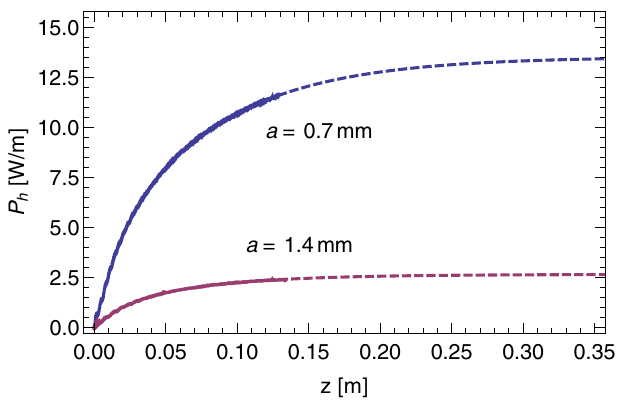
FIG. 12. Beam on axis between two plates: Joule power calculations obtained by time-domain simulation, for plate half aperture a ¼ 0 . 7 mm (blue) and a ¼ 1 . 4 mm (blue). The beam traverses the plate from its beginning, at z ¼ 0 , to its end, at FIG. 14. The real value of the impedance Re ð Z Þ for the single- z ¼ 0 . 135 m. The dashed lines give extrapolation to steady plate example (blue curve). The broadband impedance obtained ¼ 300 kHz; the driving charge is state. Here Q ¼ 300 pC, f from the same wake is given by green dashes. The analytical rep ¼ 100 μ m. perturbation result (Fig. 6) is given by red Gaussian with σ z